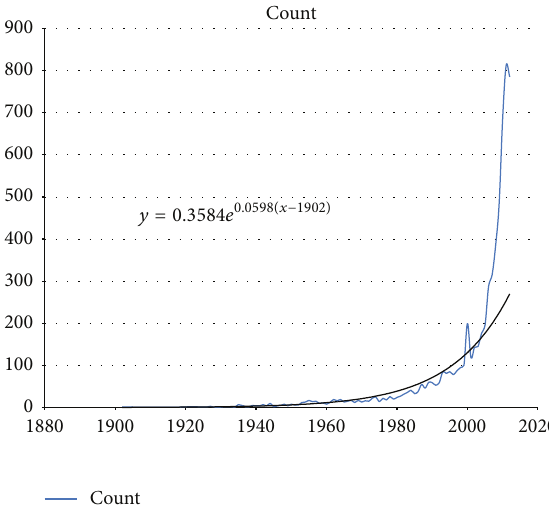
Figure 5: Statistic result of movie published in each